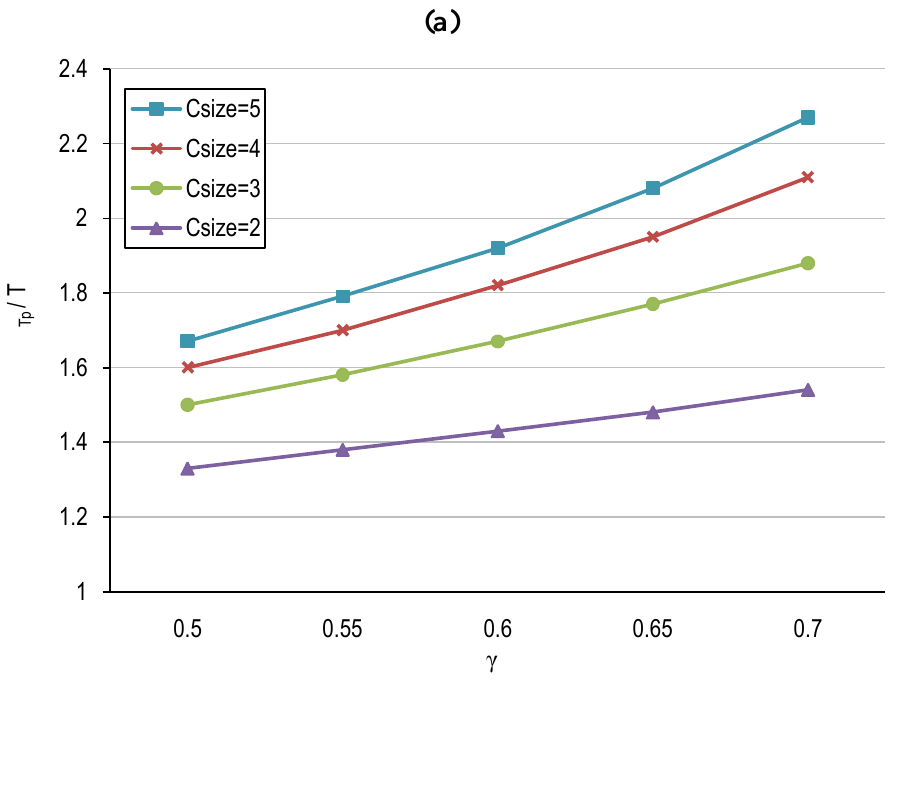
/T, (b) Cluster duty-cycle period T p